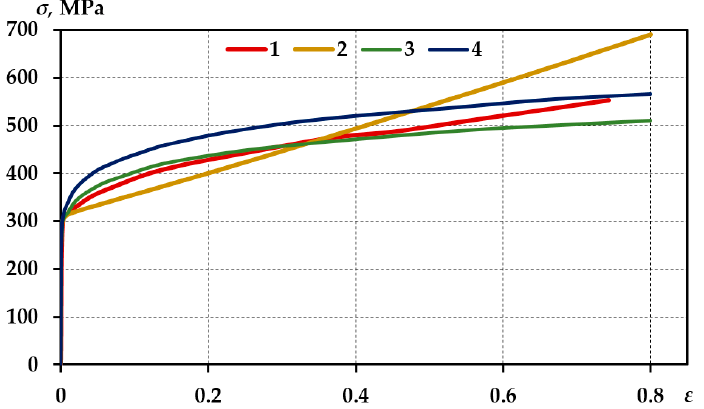
Figure 3. Approximation of points of the tensile diagram of material M2O by various laws; (1—the actual stress and deformation curve; 2—approximated with tangent modulus; 3—approximated with exponential hardening function without accounting for the real stress at break values; 4—approximated with exponential hardening function by accounting for the real stress at break value).